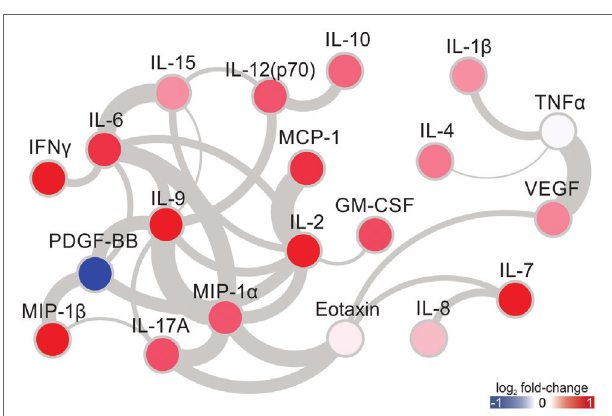
FigUre 3 | Cytokine/chemokine level correlations in Zika virus­infected subjects. Connections (edges) between two given cytokines represent direct significant correlations (Spearman p ­value < 0.05 and R > 0.5). The width of each edge is directly proportional to the R value. The node colors represent the fold­changes in cytokine/chemokine levels between infected and healthy subjects.